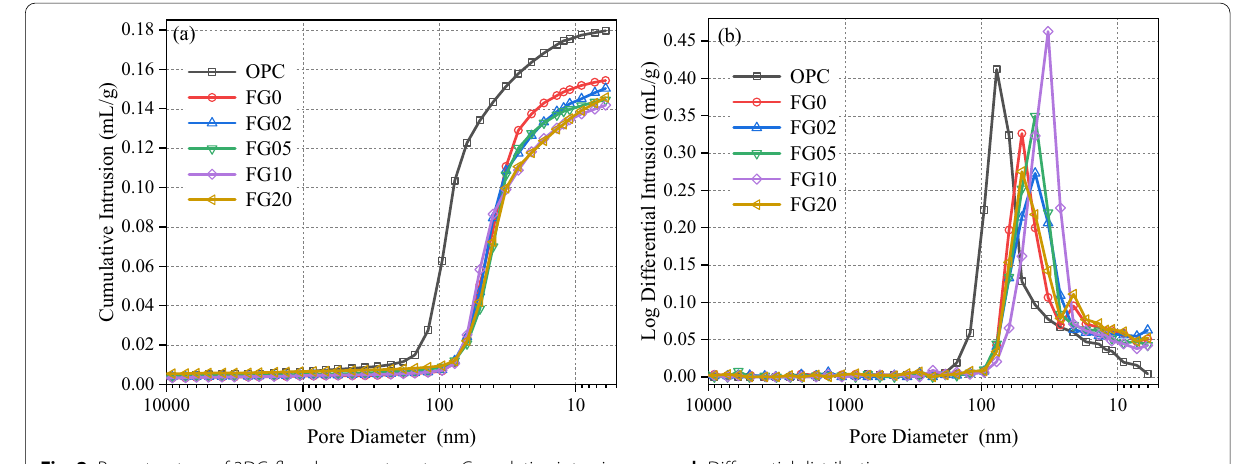
Fig. 2 Pore structure of 3DG-fly ash cement paste: a Cumulative intrusion curves; b Differential distribution Table 3 The number and composition of fly ash cement paste.